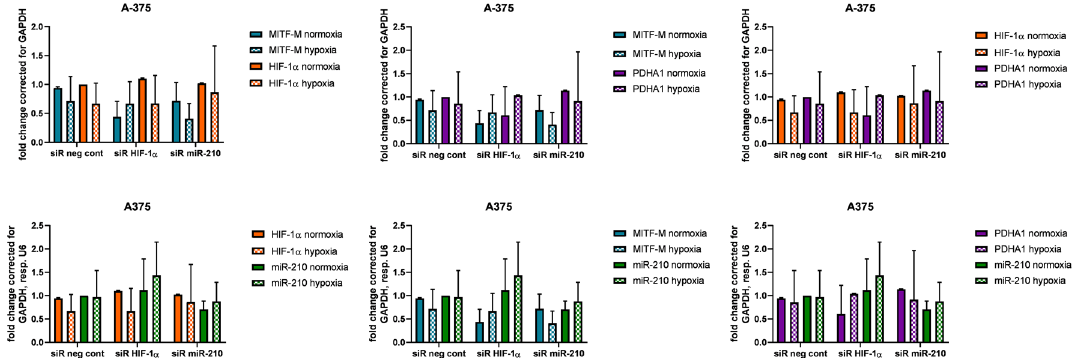
Figure 2. Relative gene expression of HIF-1α, miR-210, MITF-M, PDHA1 in normoxia and hypoxia of siR neg cont cells, siR HIF-1α, siR miR-210 (significant change with P value < 0.05 marked with *, P value < 0.01 marked with **, P value < 0.001 marked with ***). Relative expression values were analysed by REST Software (Qiagen).